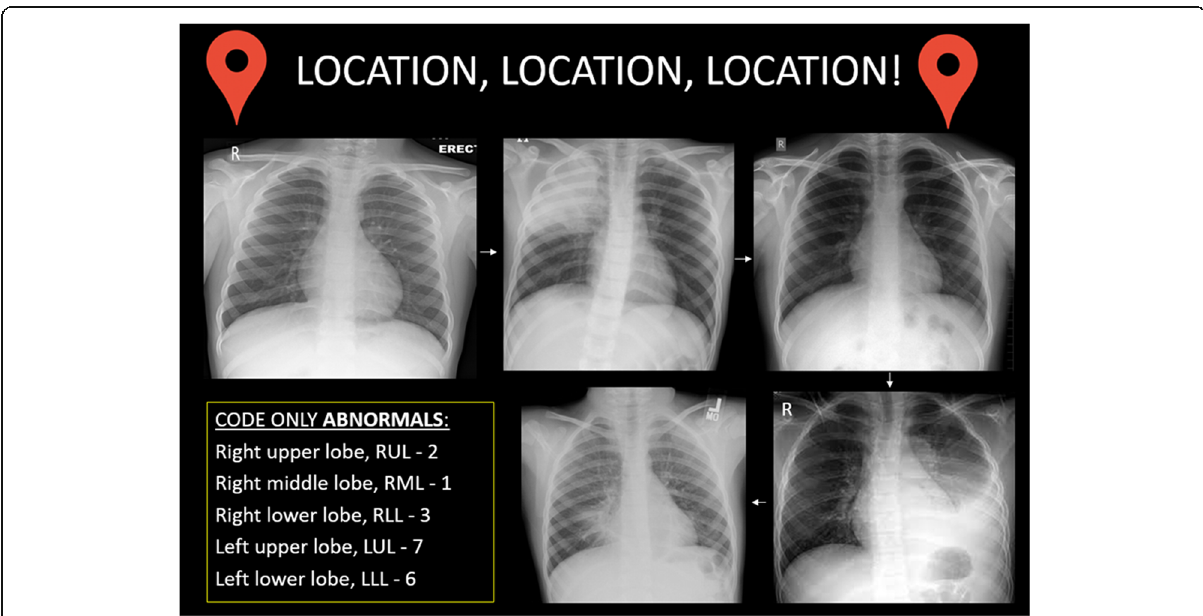
Fig. 2 ‘ Location, location, location ’ : another example of a puzzle in the escape room. The participants need to identify whether a chest radiograph is normal or abnormal. If abnormal, then the location of the consolidation should be determined and matched to the number code given in the box in the bottom left corner of the poster. For example, in this game, the three number combination is 2, 6 and 1